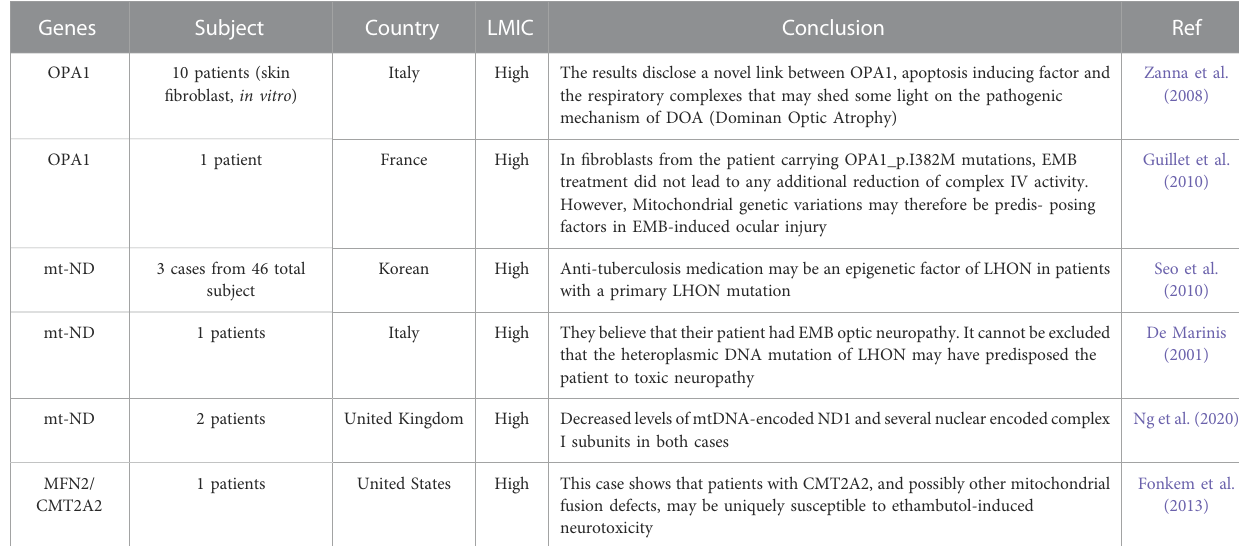
TABLE 2 Genetic polymorphism related to optic